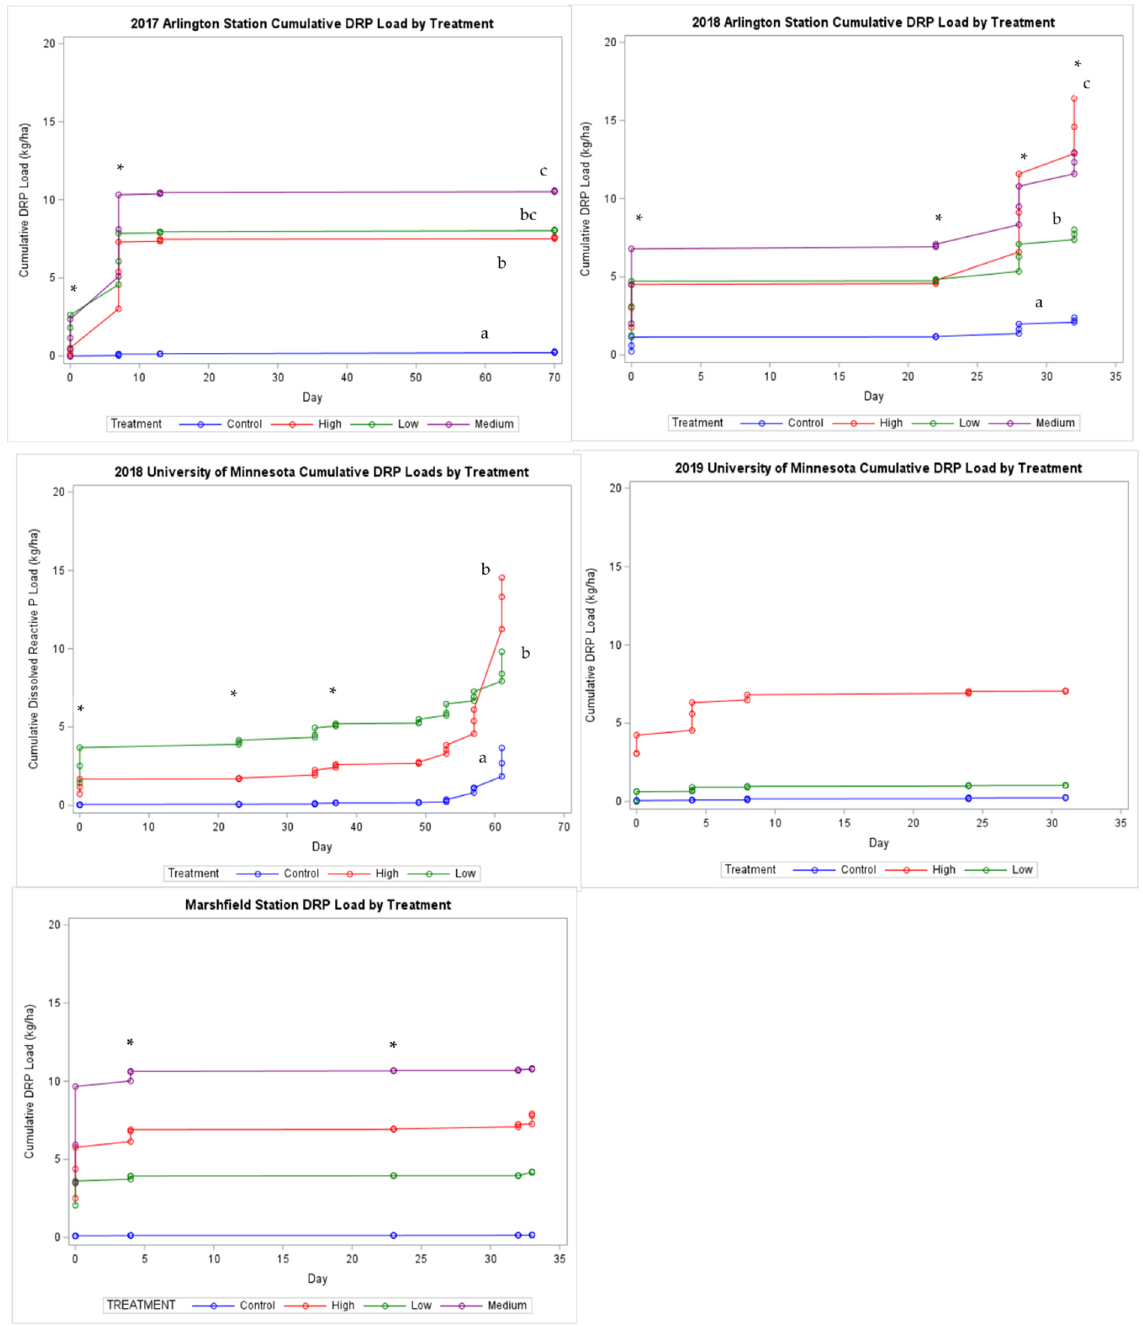
Figure 4 . Event and cumulative dissolved reactive phosphorus (DRP) loading by treatment for each site and year of the experiment. Asterisks indicate a significant ( p ≤ 0.05) main effect of manure solids. Cumulative loads without a common lower case letter differ ( p ≤ 0.05).